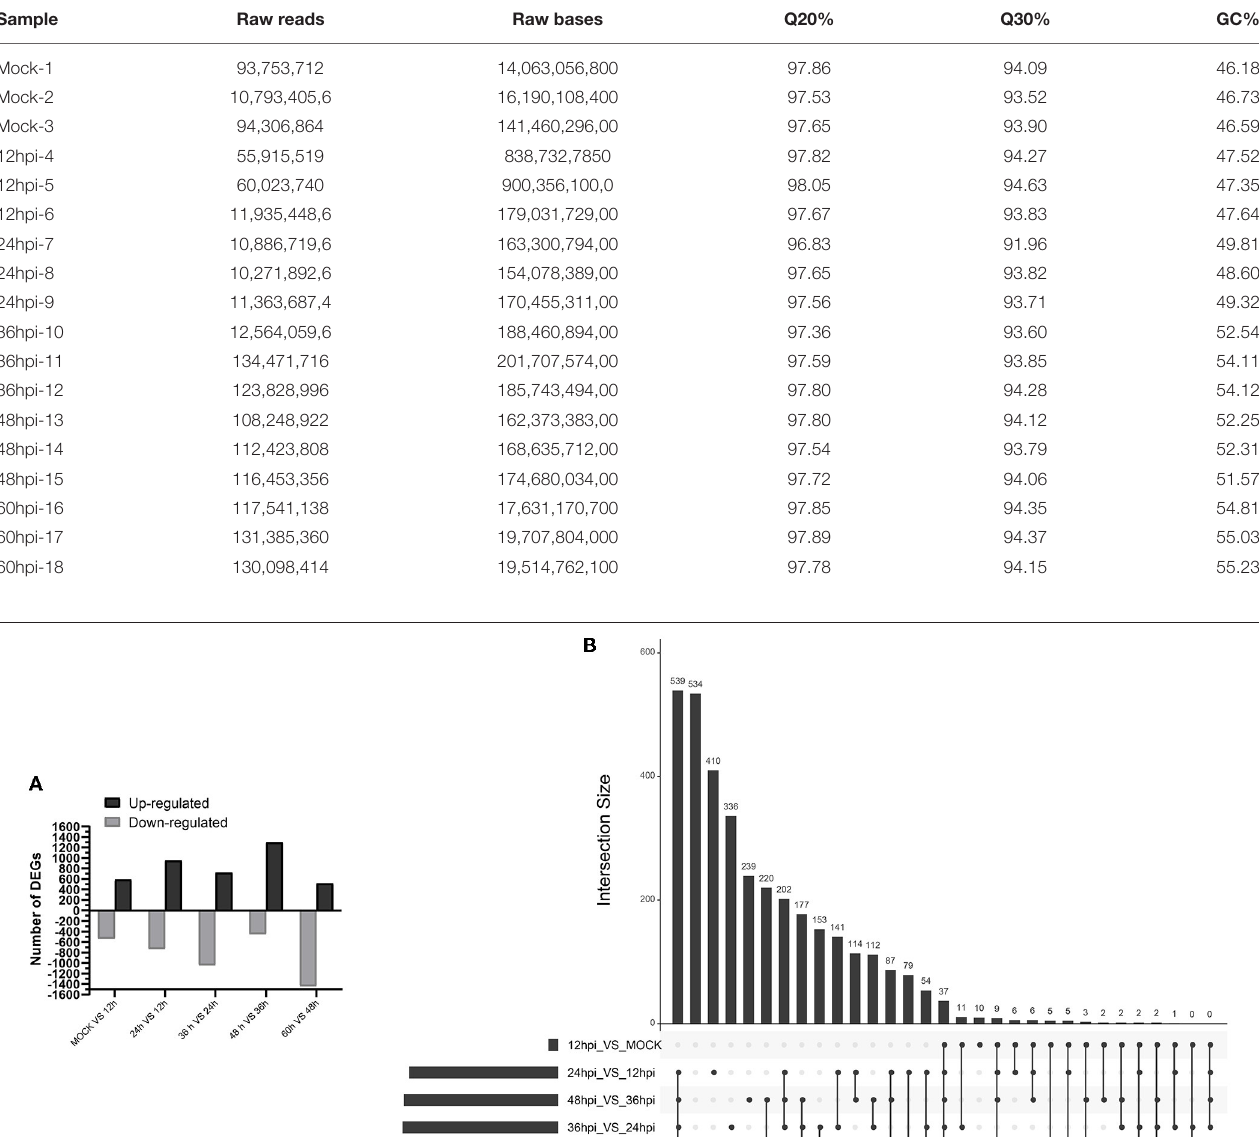
viral invasion, immunosuppression, and metabolic pathways ( Supplementary Files 6–8